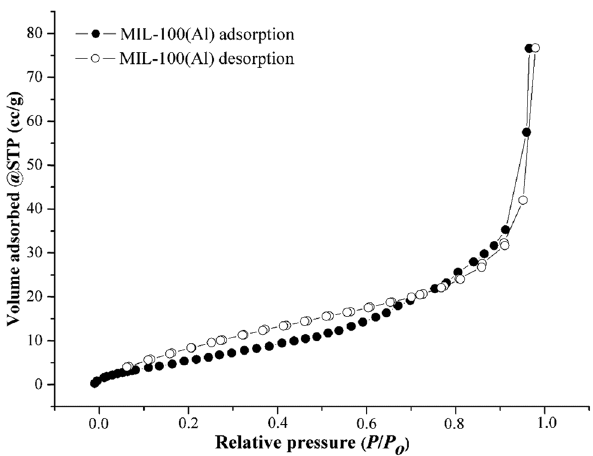
Figure 11: Nitrogen sorption isotherm analysis of MIL - 100 ( Al )